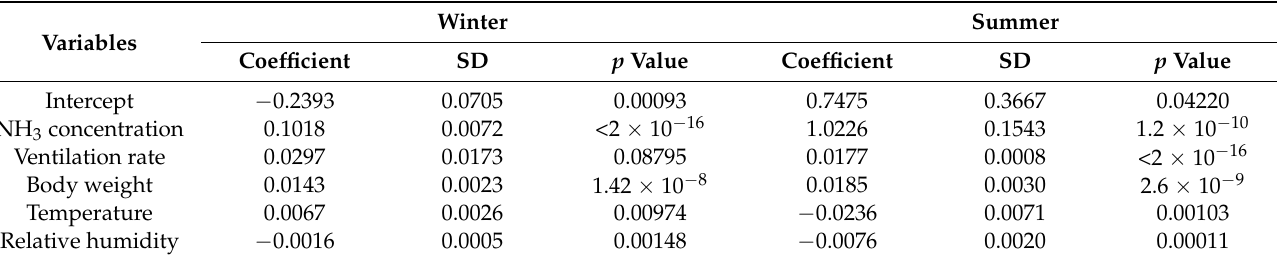
Table 4. Statistics of multiple regression analysis for ammonia emission.